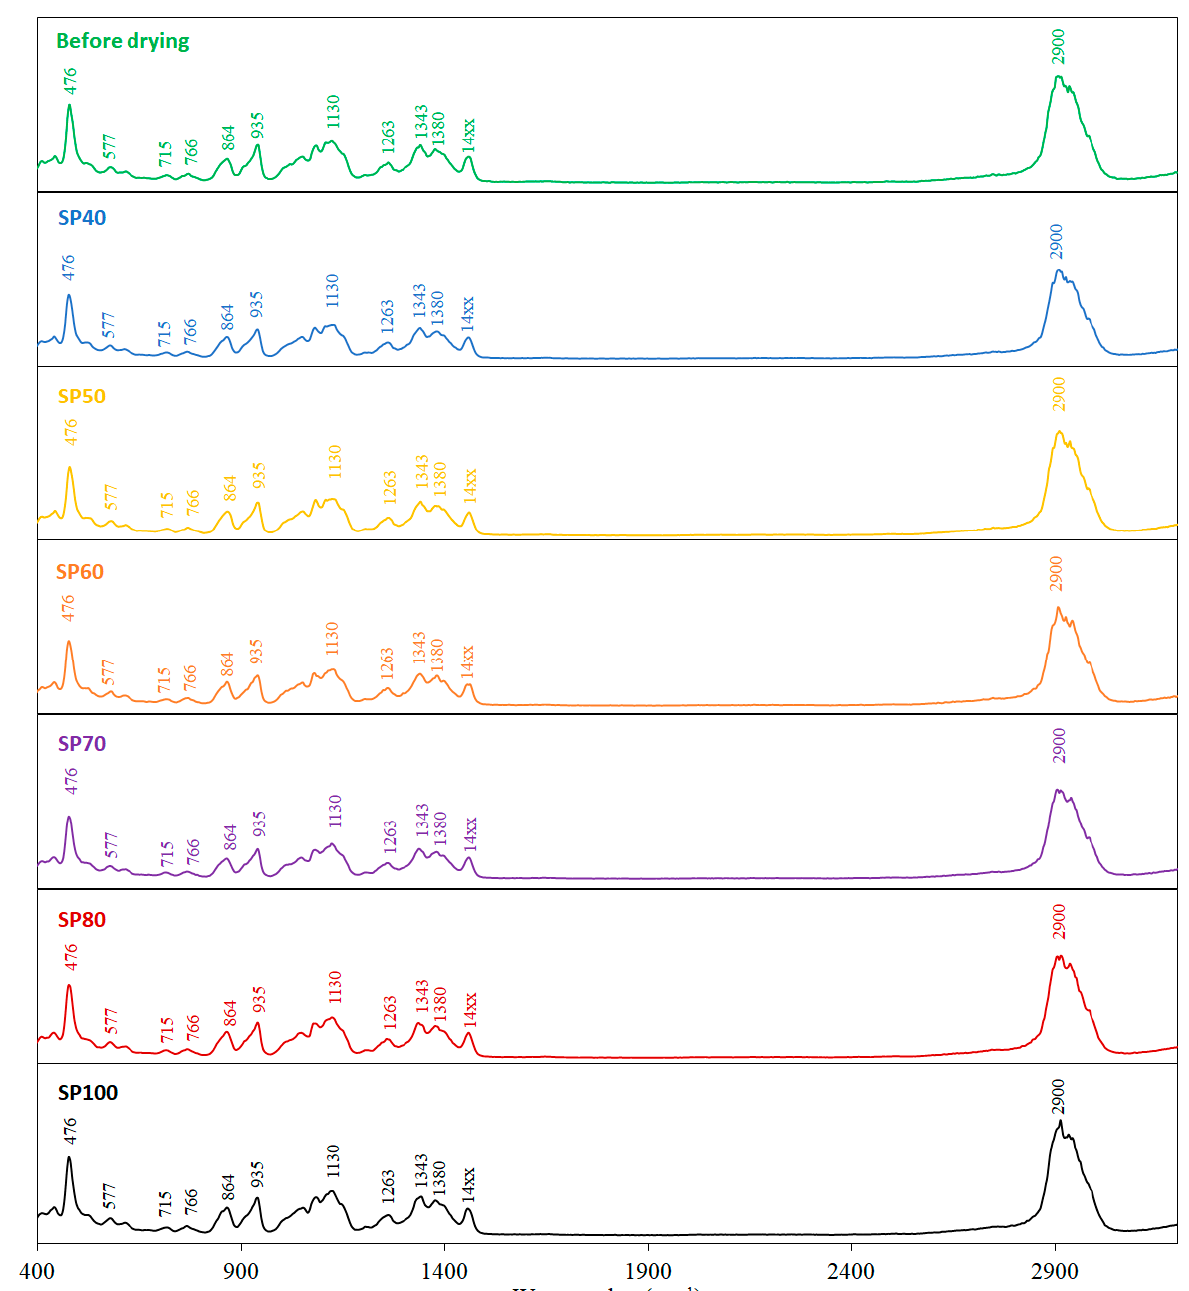
Figure 5. Raman spectra of native (Before Drying) and spray dried waxy rice starches.